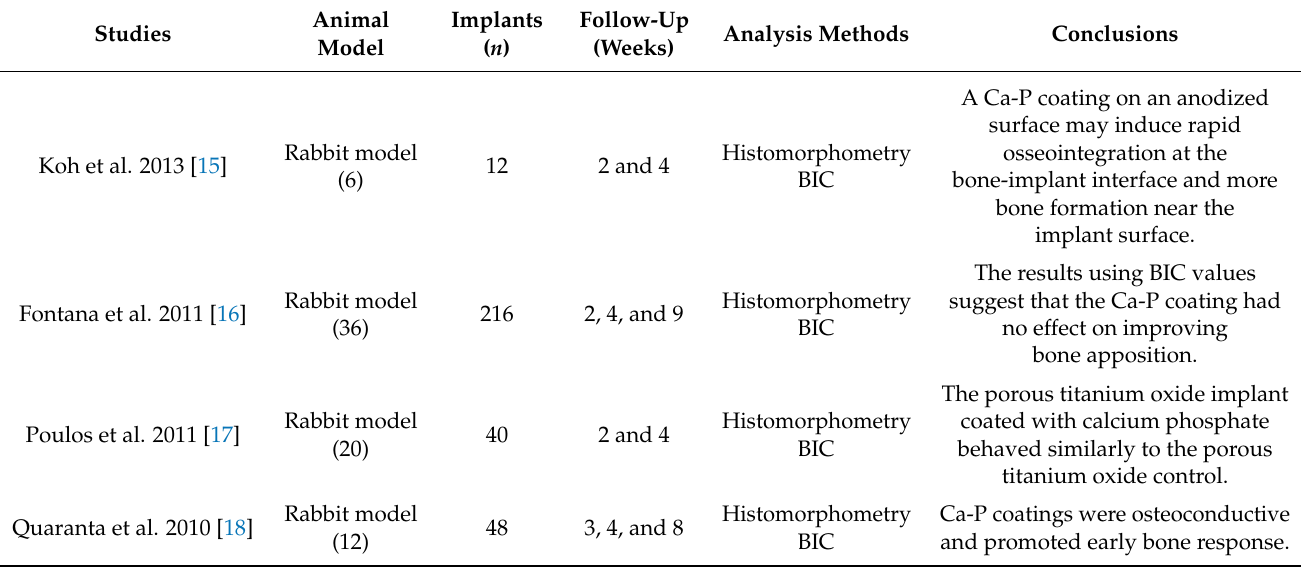
Table 3. Characteristics of the studies included.